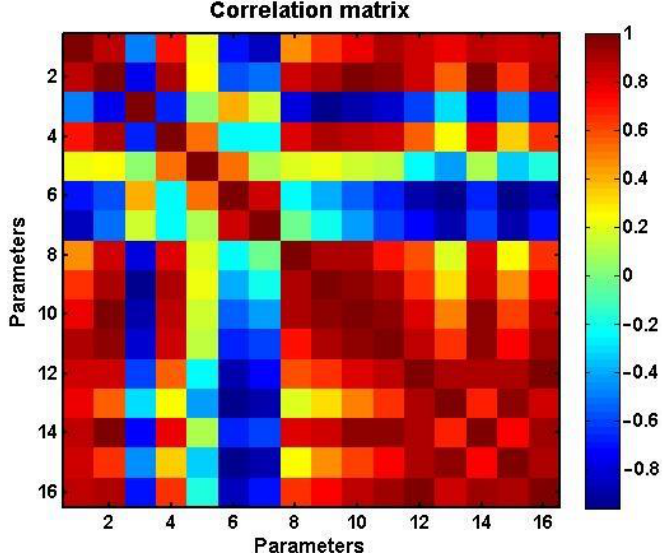
Figure 3. Tonal representation of the correlation matrix of 16 financial instruments. Table 1. Financial instruments and their respective numbers.